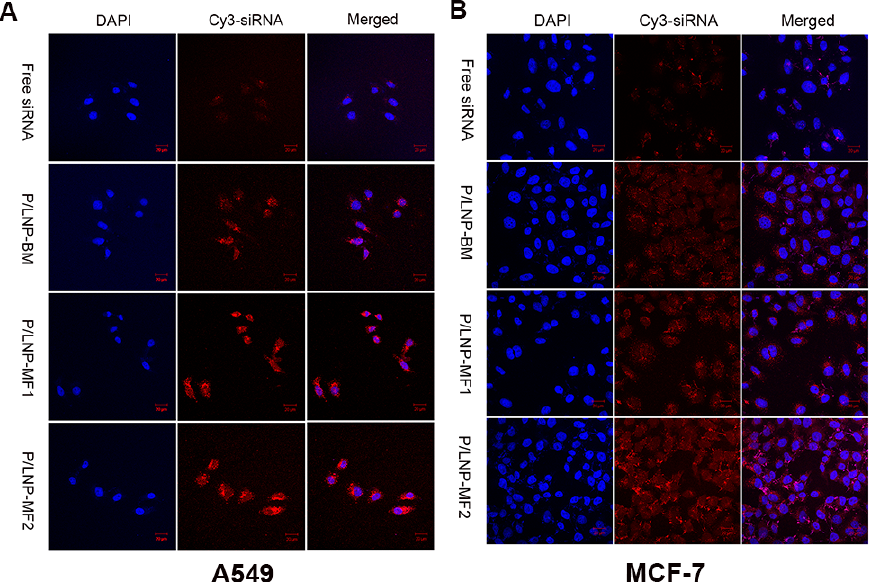
Figure 5. Confocal microscopy images of intracellular trafficking of (Cy3-siRNA loaded P/LNPs. ( A ) A549 cells; ( B ) MCF-7 cells. Cy3-siRNA is shown by red fluorescence, and DAPI ( 4 ′ -6-diamidino-2- phenylindole) stained nuclei is shown by blue fluorescence.